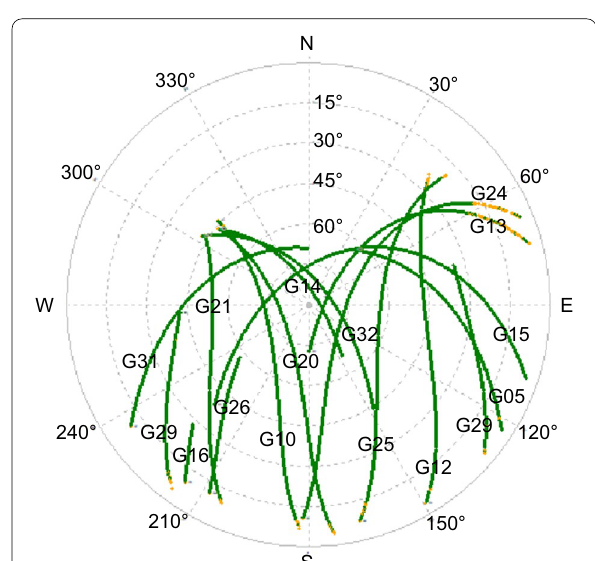
Fig. 4 GPS visible satellite sky plot of static test